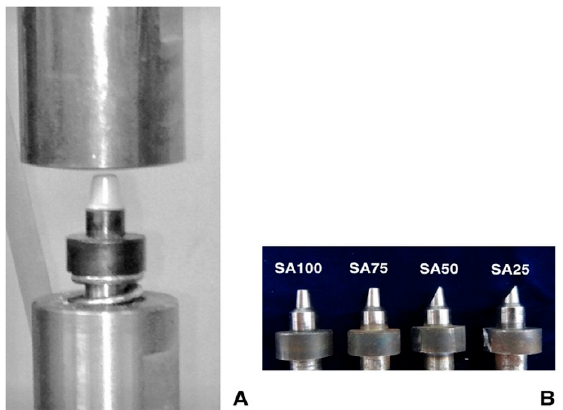
Figure 1. ( A ) Zirconia specimen and holder with spring to simulate human tissue by the servo-hydraulic testing machine; ( B ) four implant-abutment convergent occlusal surface areas. From left to right, SA100, SA75, SA50, and SA25. SA stands for the occlusal surface area, SA100 is the standard implant abutment, SA75 means 75% of occlusal surface area relative to SA100, and so on.